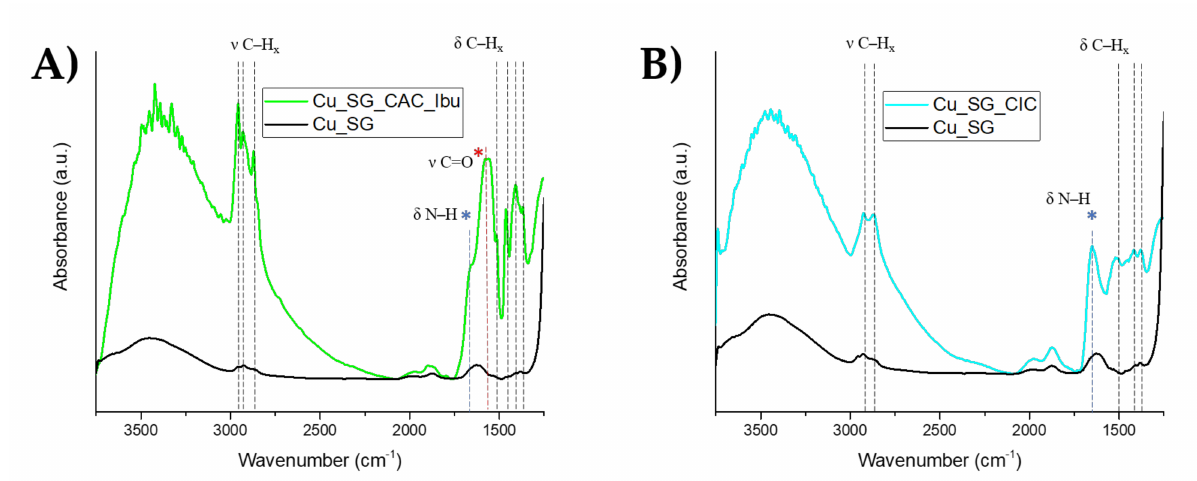
Figure 5. FT-IR spectra of ( A ) Cu_SG_CAC_Ibu and ( B ) Cu_SG_CIC. Black lines denote the C–H stretching and bending, and the red line and asterisk indicates the C=O stretching of the carboxylate groups and the blue line and asterisk indicate the N–H